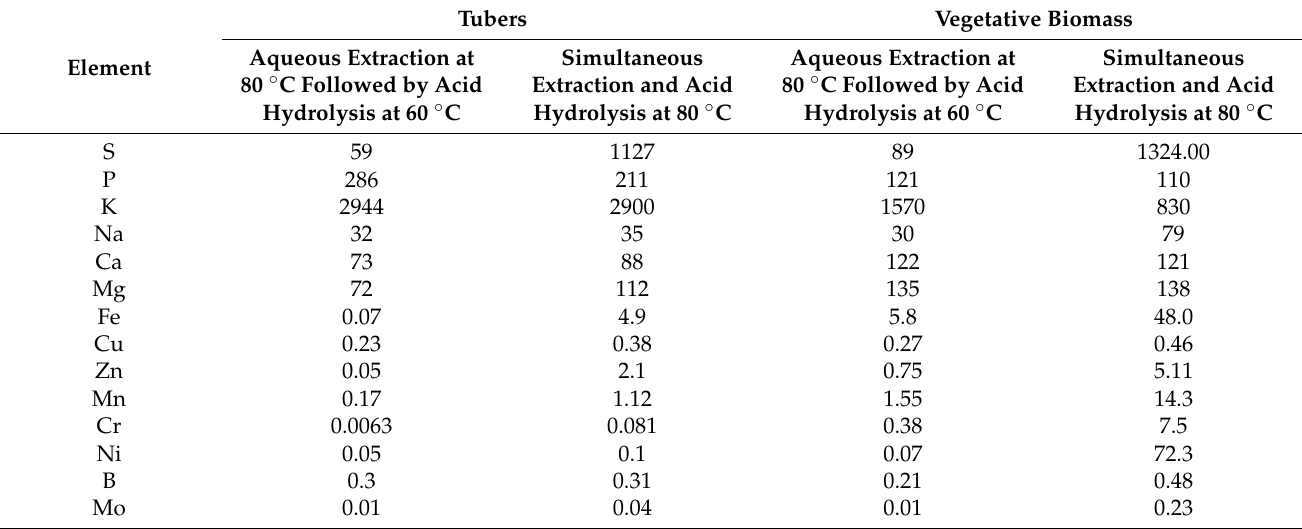
Table 3. Mineral elements in hydrolysates of Jerusalem artichoke cv. Interes